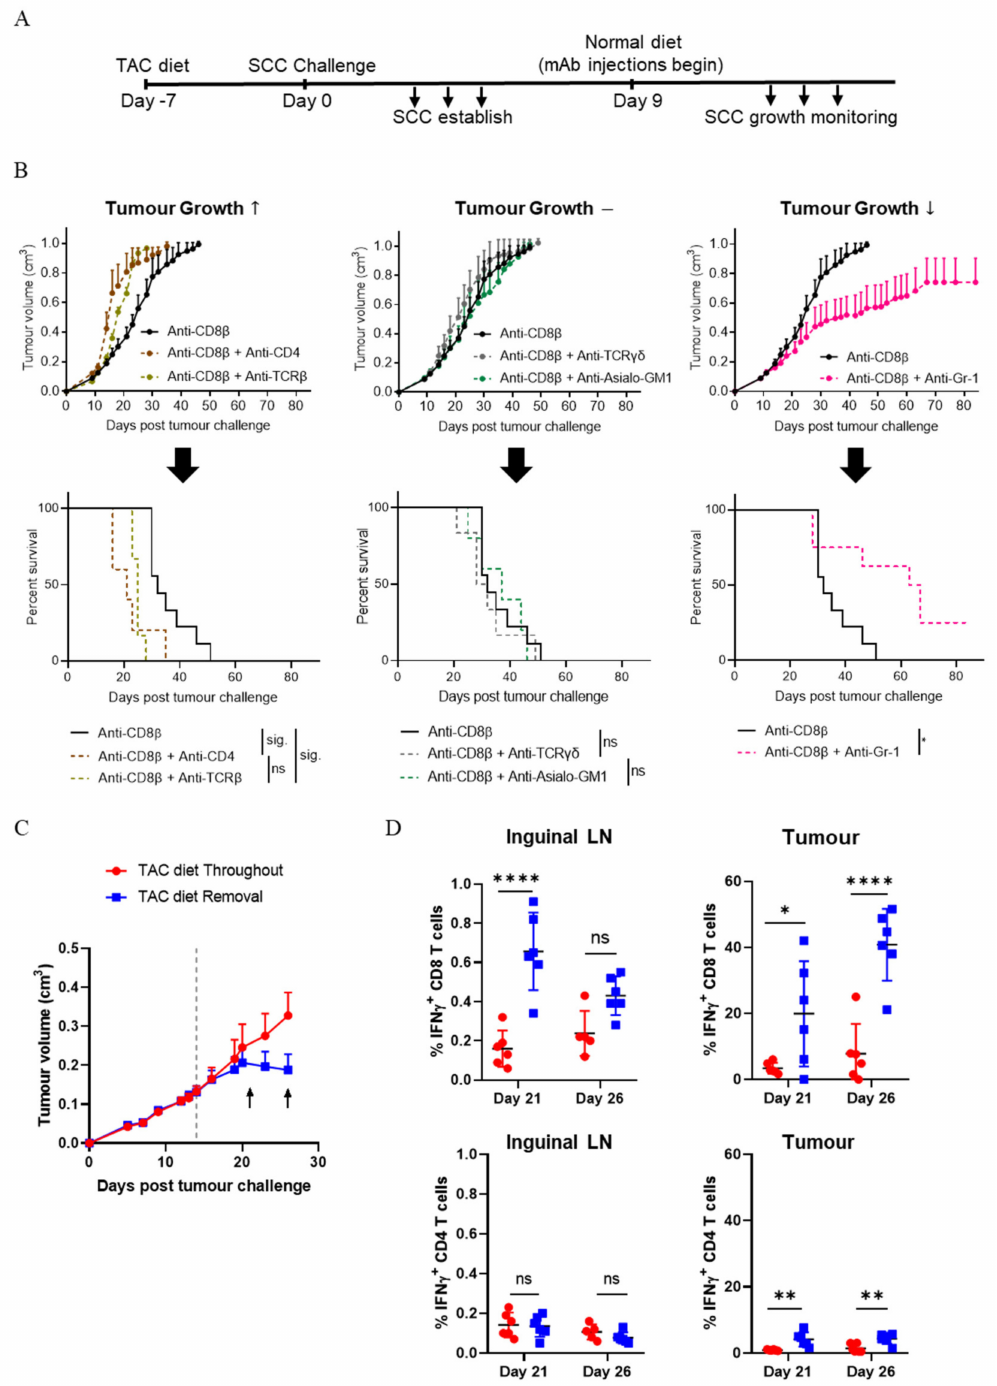
Figure 2. Multiple immune subsets impact upon SCC growth rate. ( A ) Treatment schedule for immune subset depletion experiments. ( B ) Tumour growth rate and corresponding survival curves following depletion with the indicated antibodies. Combined data from 3 independent experiments (mean ± SEM) shown, n = 5–13/group. Survival analyses was performed by Log-rank (Mantel-Cox) test. Results then displayed as significant (sig.) or not significant (ns) after bonferroni-corrected multiple comparison test (bottom left and bottom middle). Bonferroni-corrected threshold = 0.016, K = 3. Bottom right: Survival analyses was performed by Log-rank (Mantel-Cox) test (*, p < 0.05; **, p <0.01; ****, p <0.0001). ( C ) Time points assessed for T cell-associated IFN- γ production in lymph nodes and tumours of mice undergoing SCC regression. TAC diet removed on day 14 as indicated by horizontal dotted line. Arrows indicate harvest timepoints (left, day 21; right, day 26). Mean ± SEM, n = 12/group. ( D ) Analysis of day 21 and day 26 CD8 + -and CD4 + T cell IFN- γ production as described in ( C ). n = 6/time point/group. Two-way ANOVA, bars represent mean ± SEM, data points represent individual